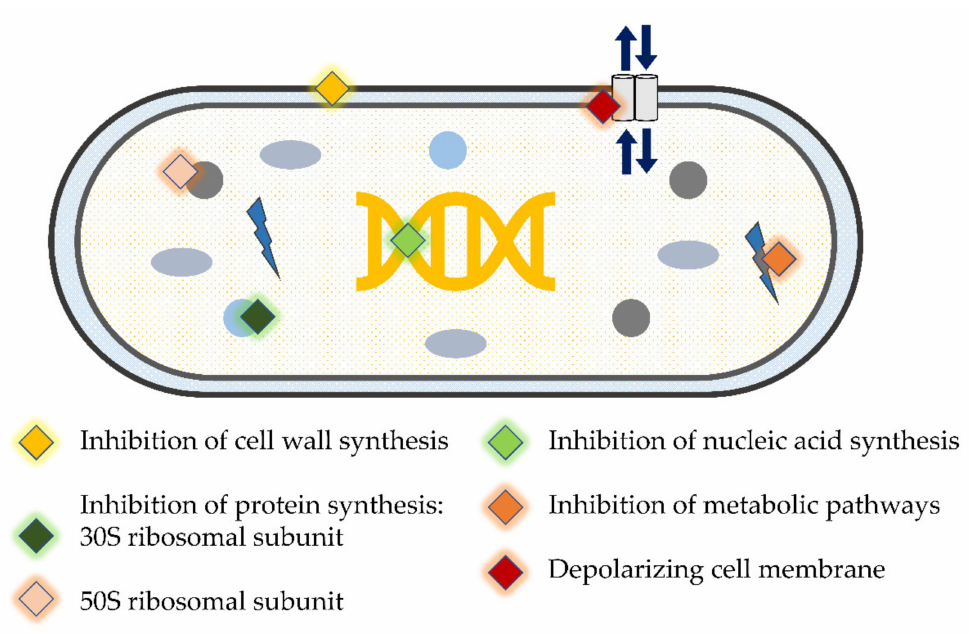
Figure 2. Mode of action of antimicrobial